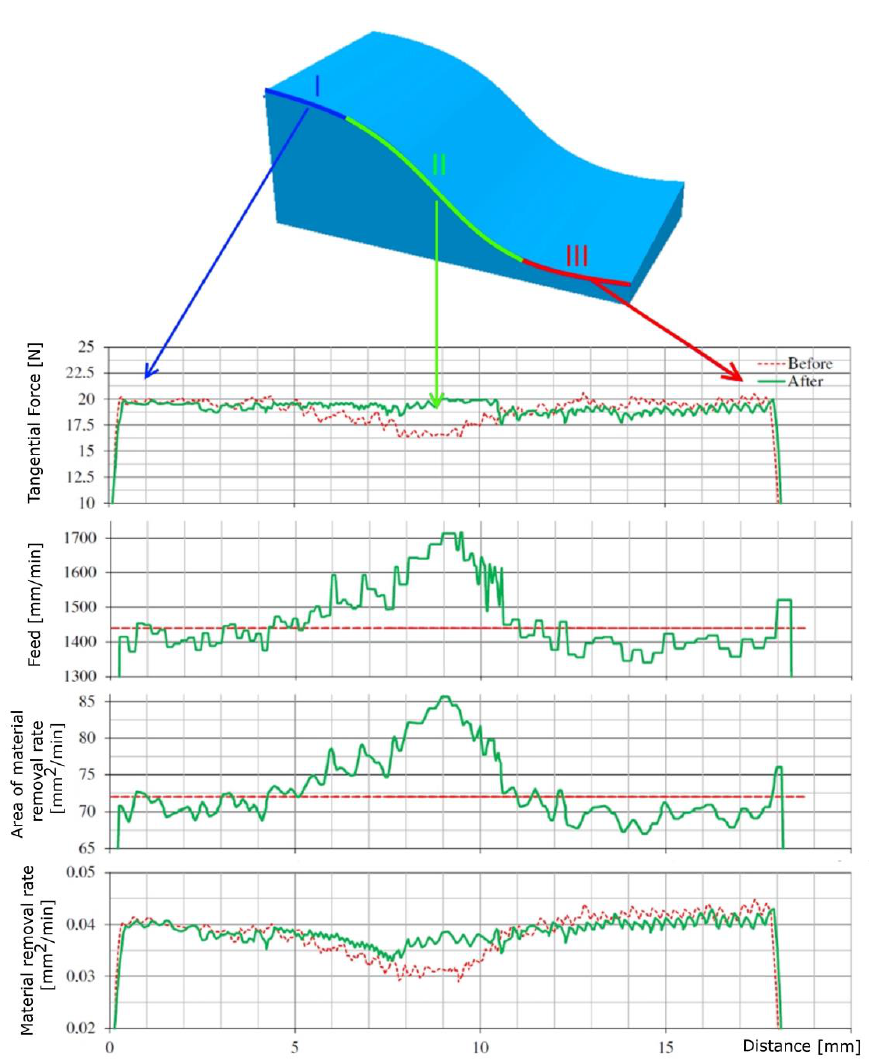
Figure 13. Courses of the tangential component of the total cutting force and the change of the feed rate and machining process e ffi ciency obtained for Stage II.